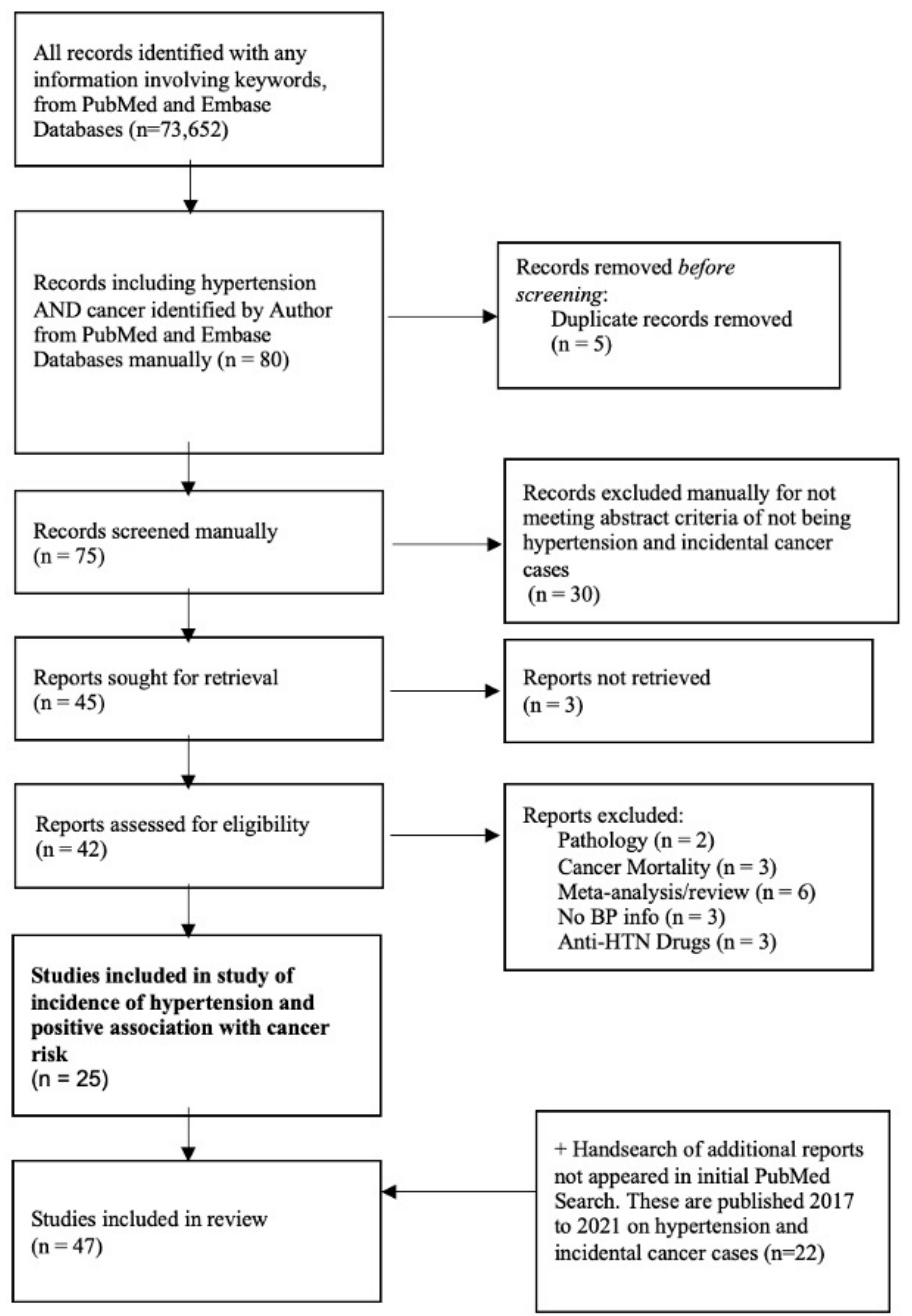
Figure 1. Flowchart of the studies excluded during a manual literature search conducted over five months.